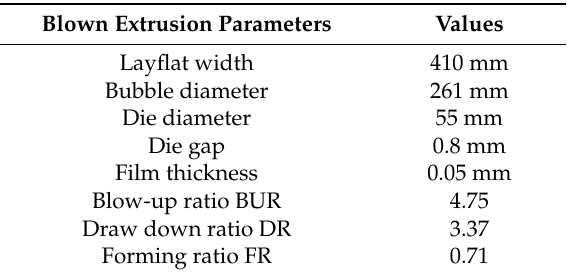
Table 1. Blown extrusion